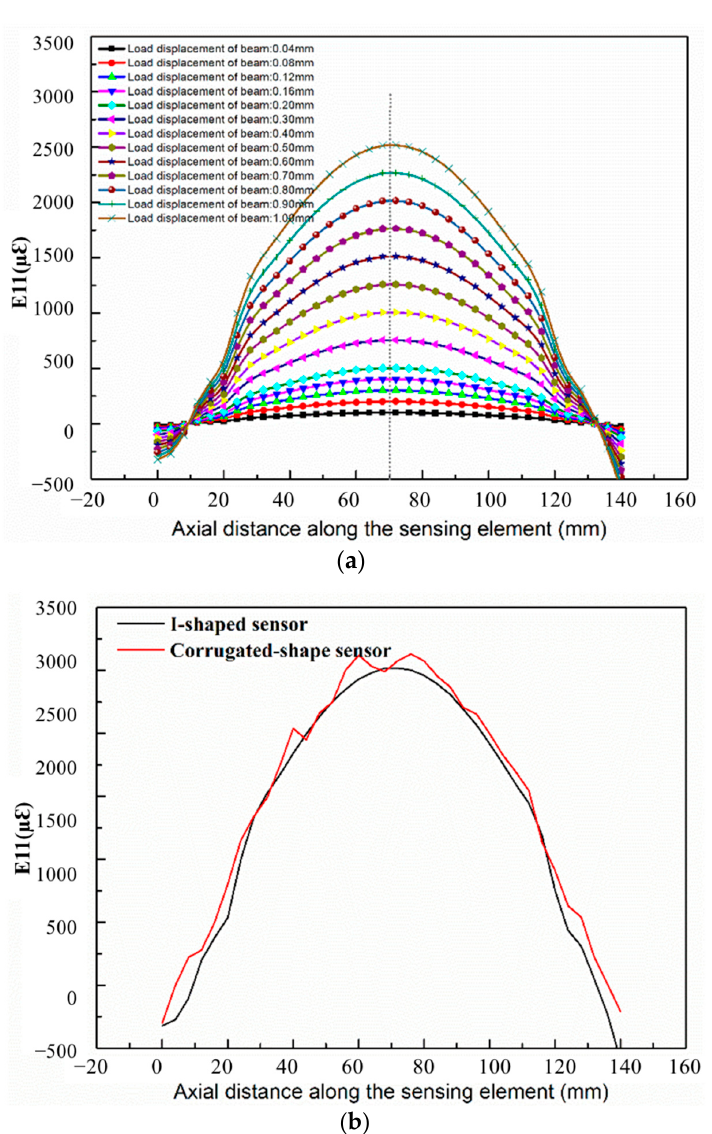
Figure 8. The change of horizontal tension strain E11 along the axial distance of the sensor, ( a ) I- shaped sensing element, ( b ) comparison of two structural sensors.